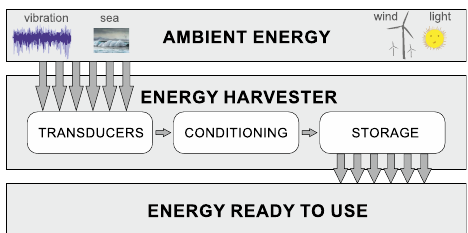
Figure 1. Typical energy harvesting